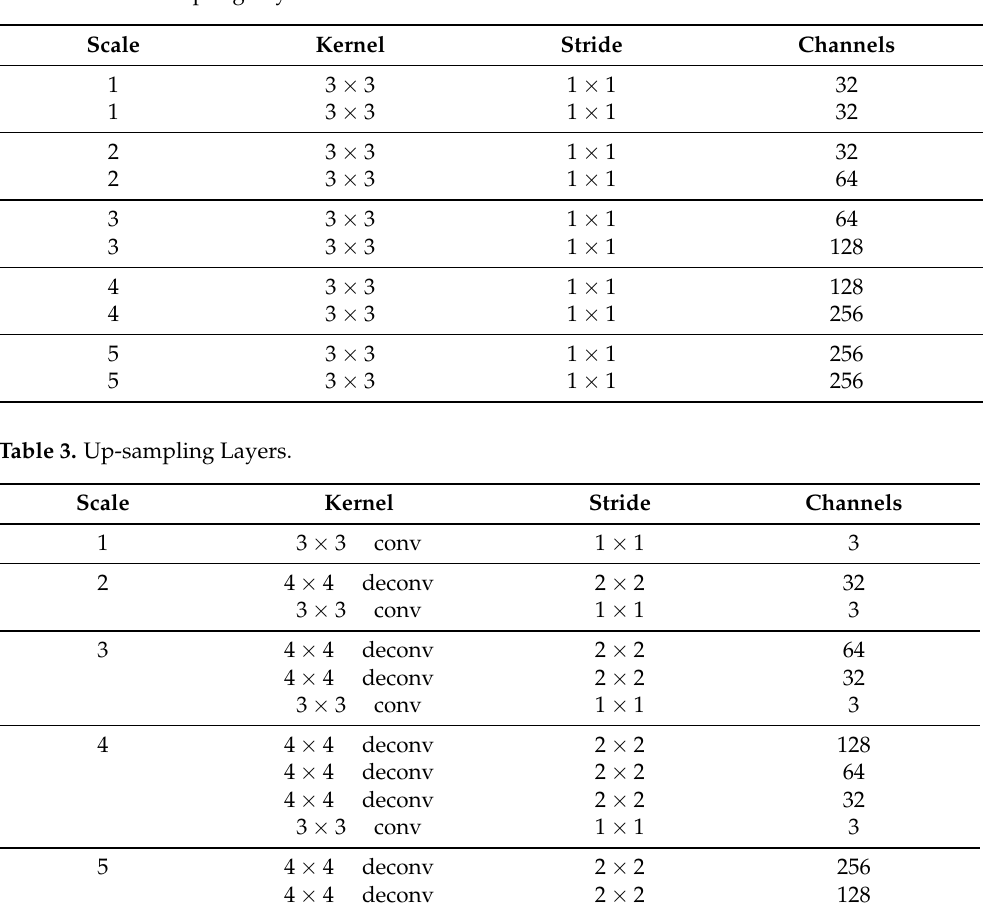
Table 2. Down-sampling Layers.